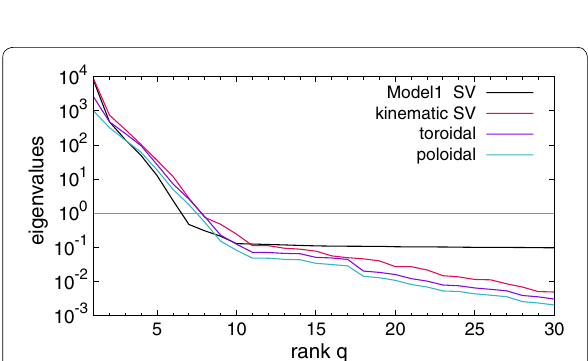
Fig. 15 The eigenvalue spectra of the classical, kinematic secular variation, toroidal and poloidal flow variability, respectively. The horizontal line marks eigenvalues equal